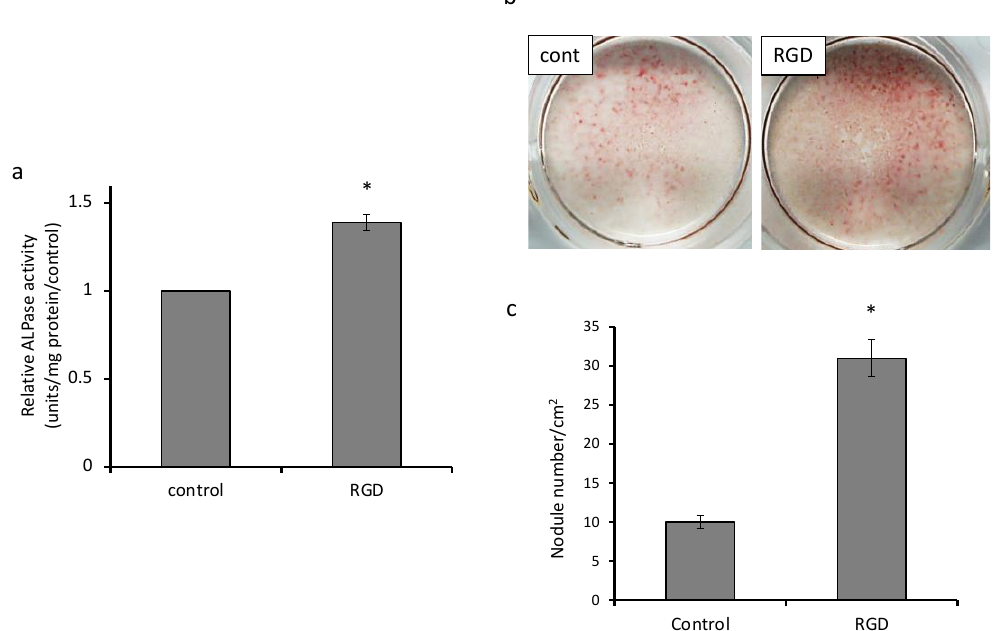
Figure 2. Analysis of differentiation and mineralization ( n = 3). ( a ) ALP activity of MDPC-23 cells in the experimental group was approximately 1.4 times higher than that in the control group on day 7 (* p < 0.01). ( b ) The mineralized nodules were visualized by alizarin red S staining. ( c ) The number of mineralized nodules induced by the DPP-derived RGD-containing peptide rose by approximately three times (* p < 0.01).